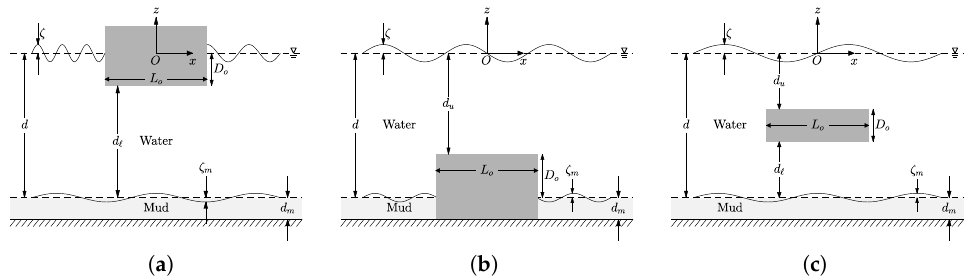
Figure 1. Schematic of wave scattering by a fixed obstacle above a fluid mud bottom: ( a ) surface obstacle; ( b ) bottom obstacle; ( c ) submerged obstacle. d = constant water depth before and after the obstacle. d m = thickness of the mud layer. L o , D o = length and submerged depth of the obstacle. d u , d (cid:96) = depths above and below the obstacle. ζ , ζ m = displacements at the free-surface and the water–mud interface. ( x , z ) = horizontal and vertical